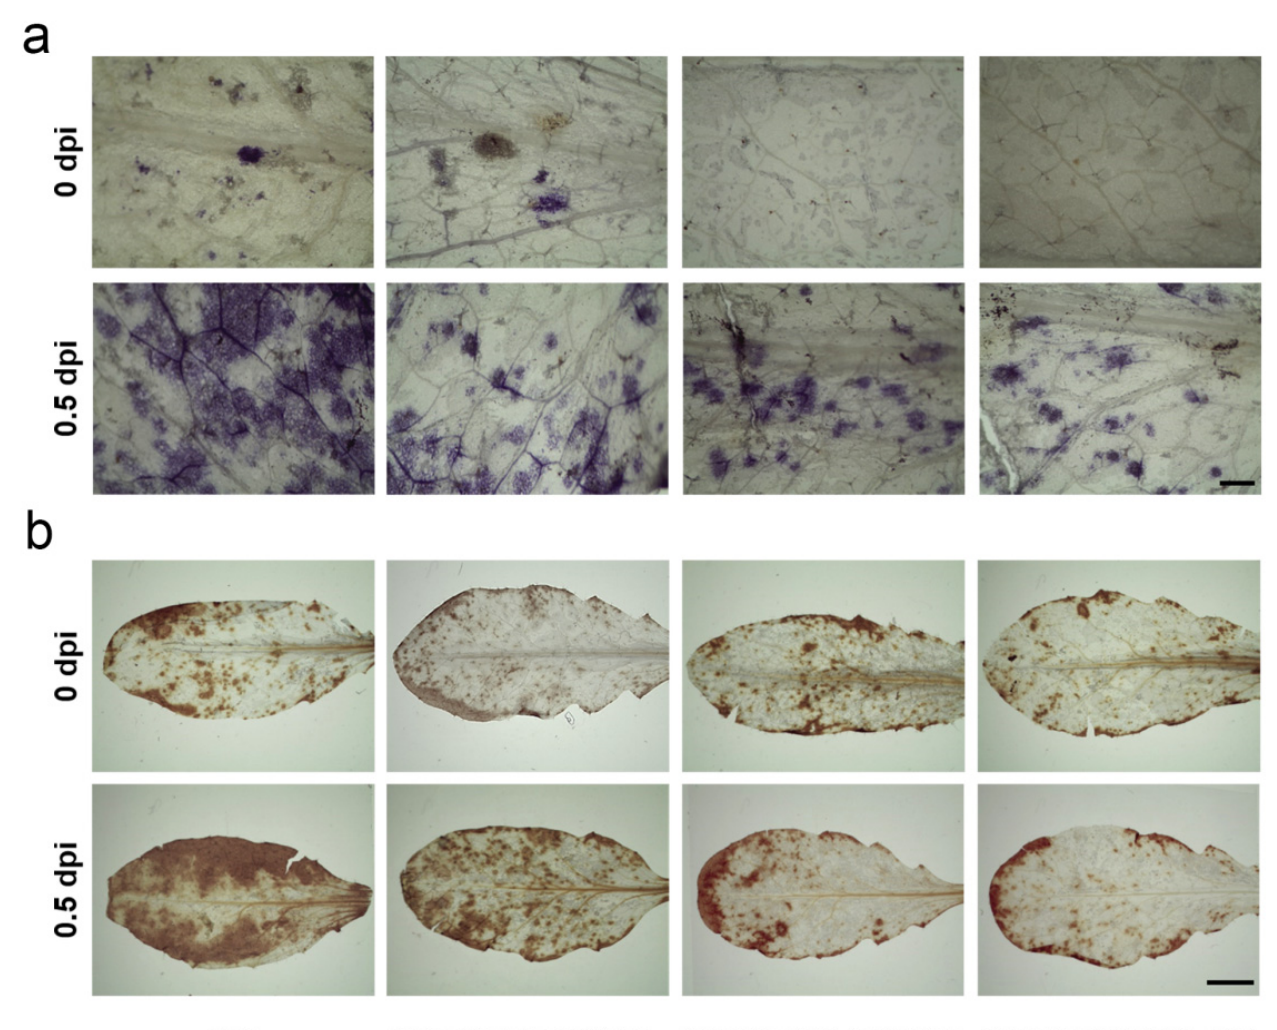
Figure 6. Effect of CmbHLH18 on ROS accumulation in leaves in Arabidopsis after inoculation with A. brassicicola . ( a ) Accumulation of O 2 − (NBT staining) (Bar = 1cm); ( b ) Accumulation of H 2 O 2 (DAB staining) (Bar = 100 μ m).